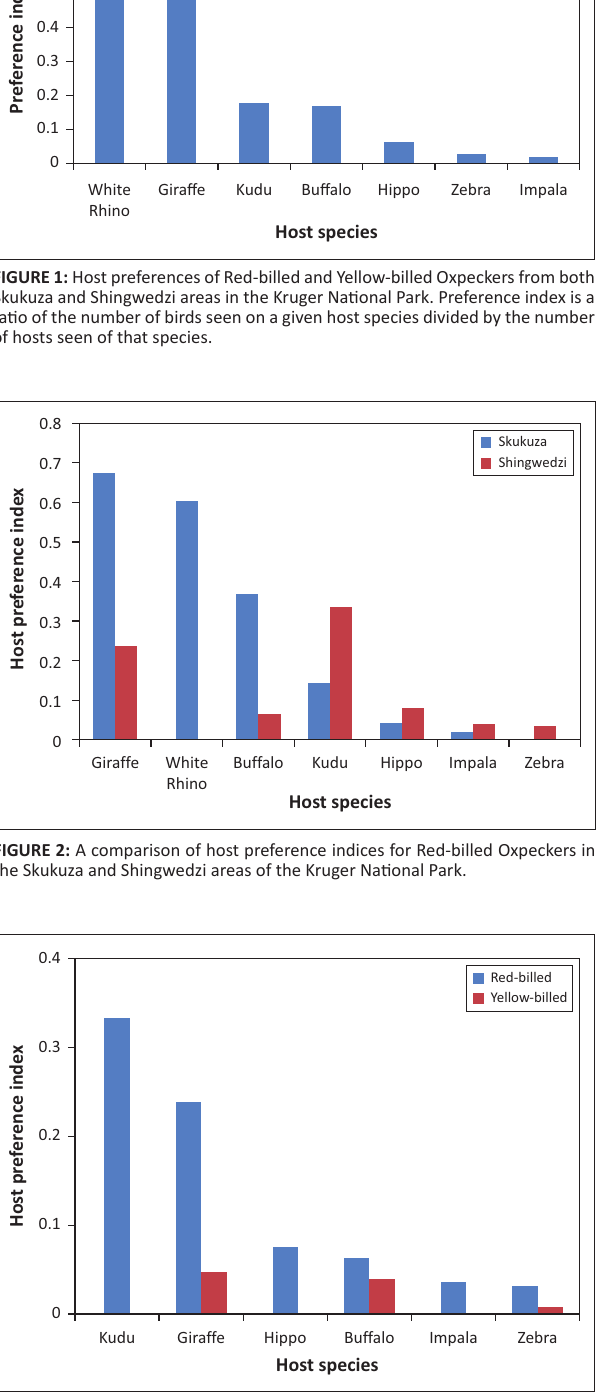
FIGURE 3: A comparison of host preference indices for Red-billed and Yellow- billed Oxpeckers in the Shingwedzi area of the Kruger National Park.